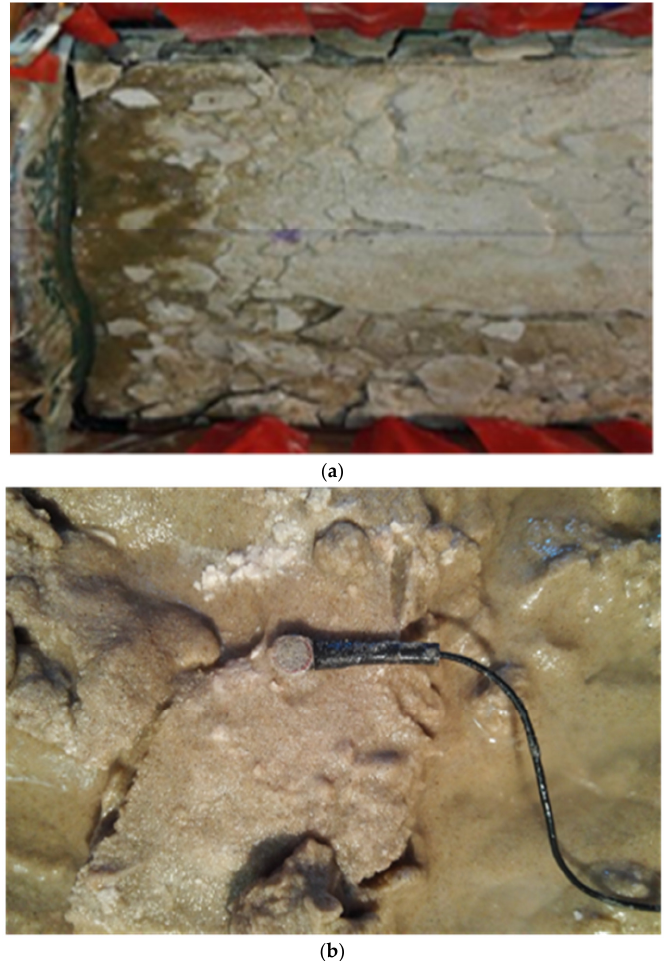
Figure 5. Metallogenic surface of the sandy soil. ( a ) Fragmentation of the surface calcium carbonate layer. ( b ) Sensor installation.